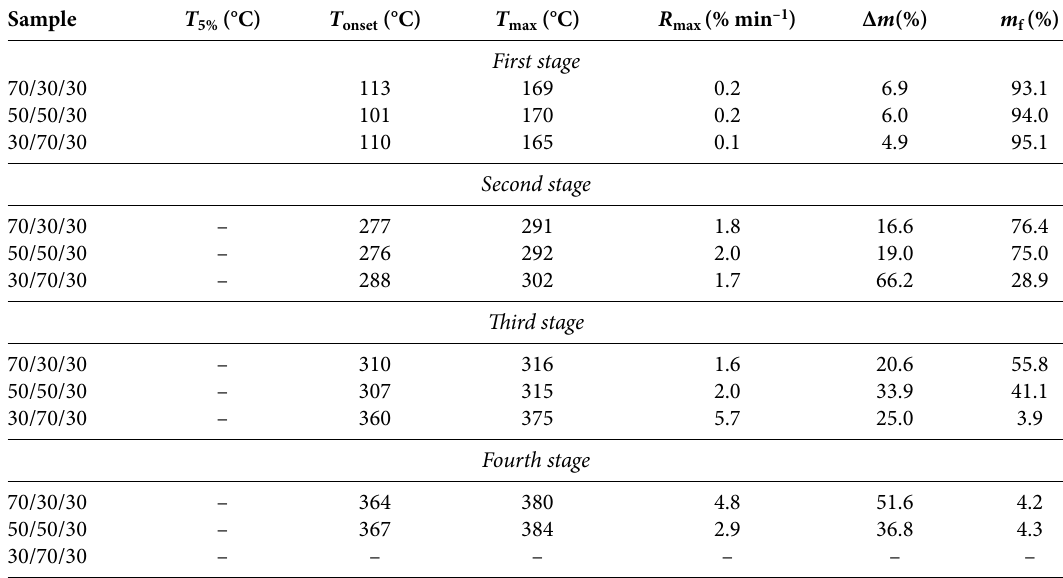
Table 3. The characteristics of thermal degradation curves of PCL/PLA/TPS blends (heating rate 2.5 °C min –1 )